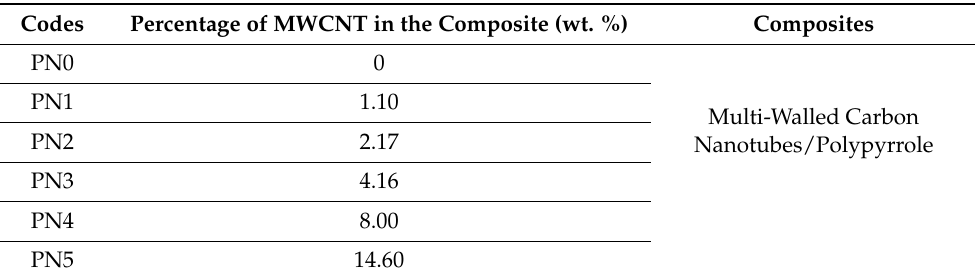
Table 1. Cods and multi-walled carbon nanotubes (MWCNTs) wt.% used for different nanocomposites.